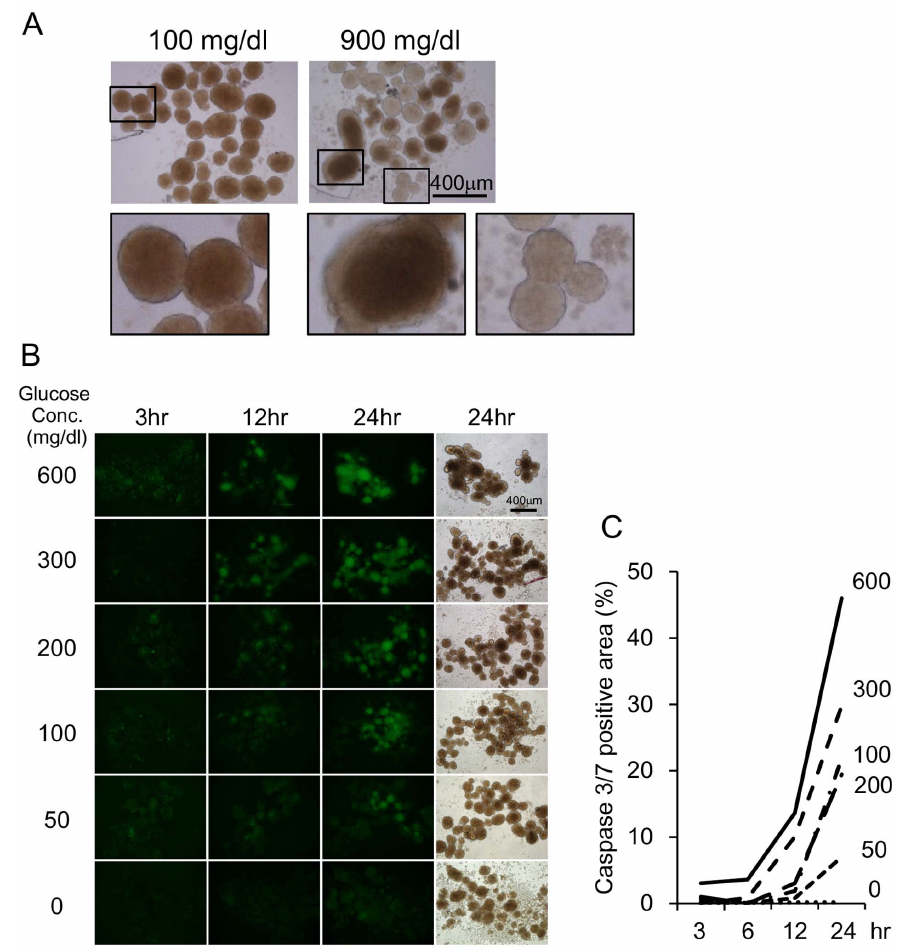
Figure 4. Islet apoptosis increased with increasing glucose concentration. (A) Islets were cultured in low-glucose (100 mg/dL, left) and high-glucose (900 mg/dL, right) media for 24 hours. Lower panels show high-magnification images. (B) The caspase-3/7–positive area increased after a 24-hour exposure to various glucose concentrations from 0 to 600 mg/dL. (C) Quantitative analysis of Figure 5B: media with glucose concentrations of 0 mg/dL (dotted line), 50 mg/dL (small broken line), 100 mg/dL (dot-broken line), 200 mg/dL (large broken line), 300 mg/dL (middle broken line), and 600 mg/dL (solid line) were used.